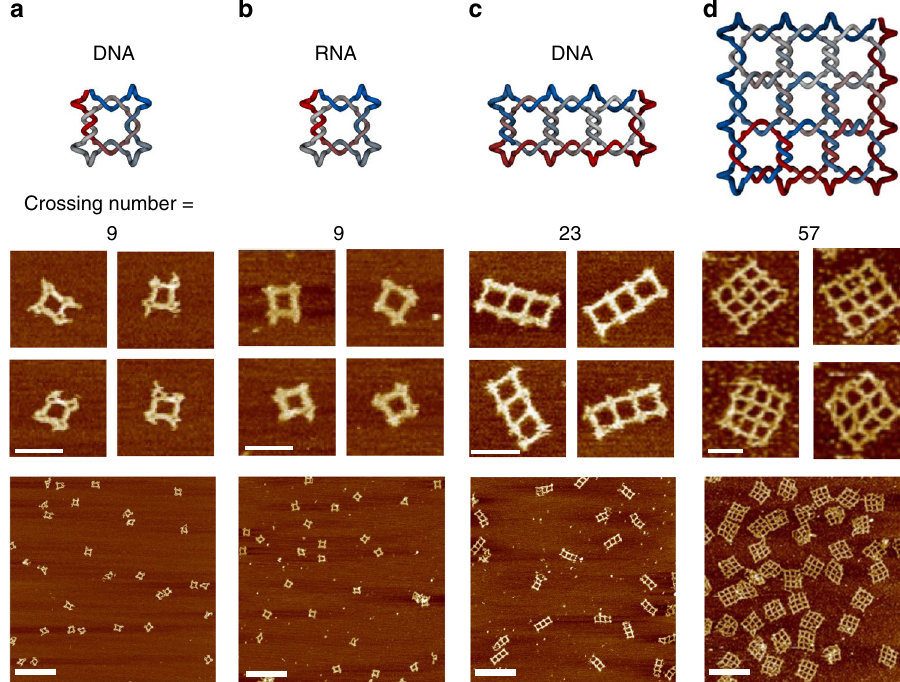
Fig. 2 Design and AFM characterization of two-dimensional single-stranded DNA and RNA knots. Designer models (top row) for the 2D nanostructures and their corresponding AFM images (middle row shows the zoomed-in images and bottom row shows the zoomed-out images) with increasing crossing numbers: a A DNA square with a crossing number of 9, b An RNA square with a crossing number of 9, c A DNA rectangle with three square cavities and a crossing number of 23, d A DNA 3 × 3 square lattice with a crossing number of 57. The color scale in the schematics indicate the routing of the large long- stem structures. The scale bars in the zoom-in images represent 50 nm, while the ones in the zoom-out images are 200